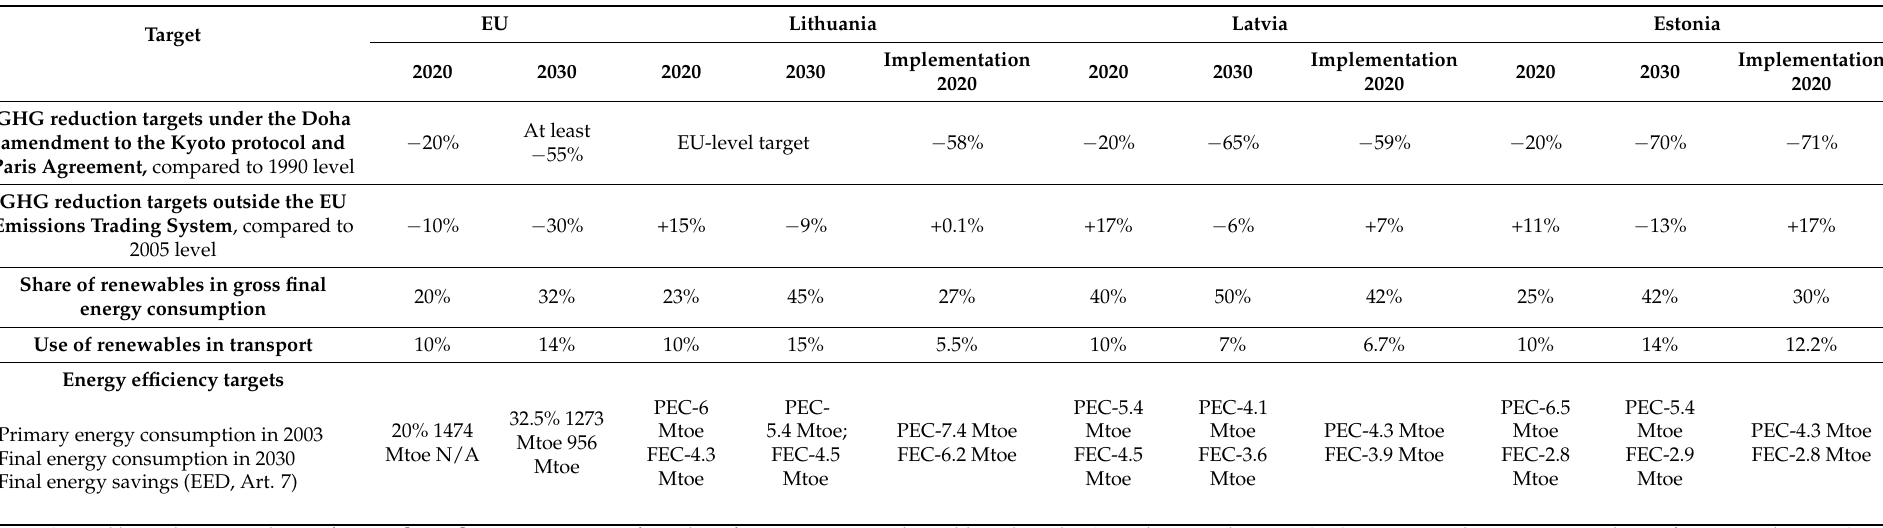
Table 2. National and EU energy and climate targets for 2020 and